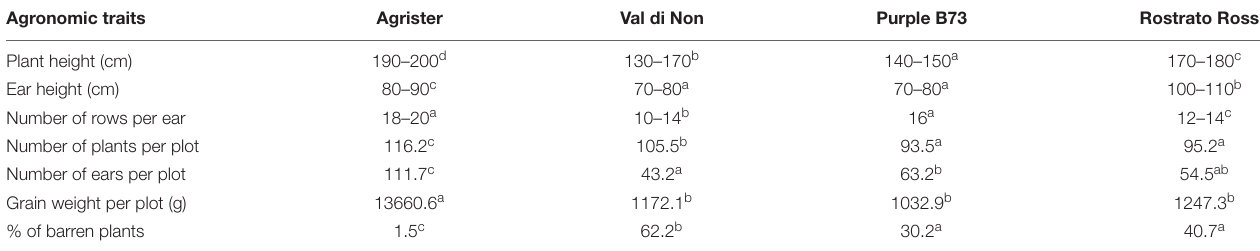
TABLE 1 | Main agronomic traits of the four maize genotypes. Agronomic